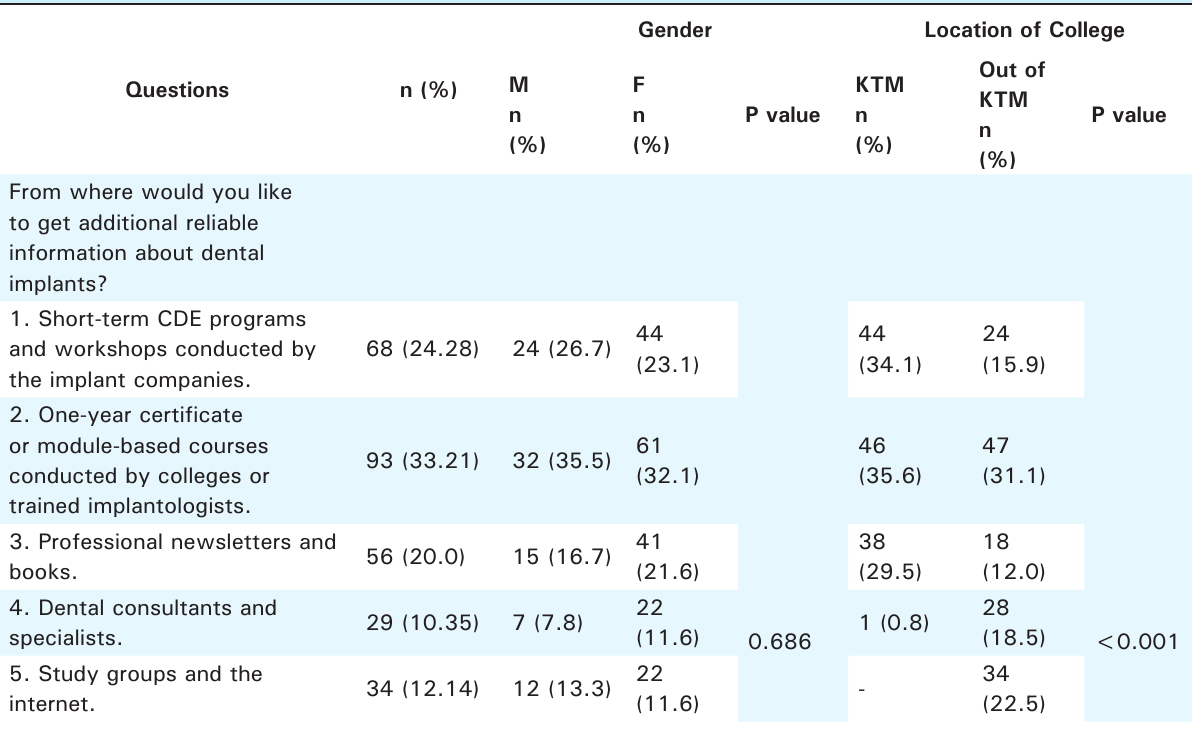
Table 5. Responses to the 12 th and 13 th questions and their associations with gender and location of